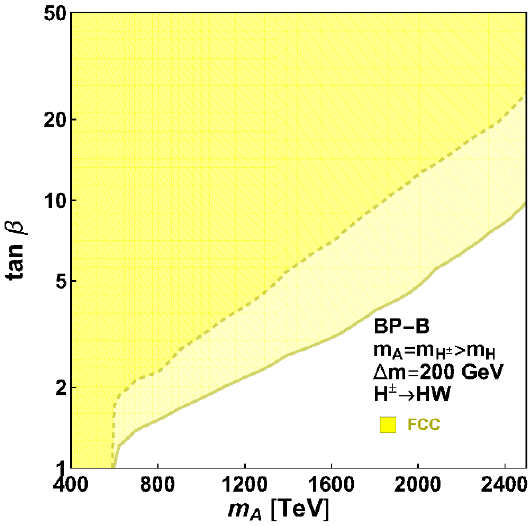
Figure 6 . Reach for the exotic decay channel H (cid:6) ! HW ! (cid:28)(cid:28) bb WW for BP-B at a 100 TeV pp collider in the tan (cid:12) vs. m A plane for m A (cid:0) m H = 200 GeV. The solid and dashed line correspond to the exclusion and discovery reach, respectively.